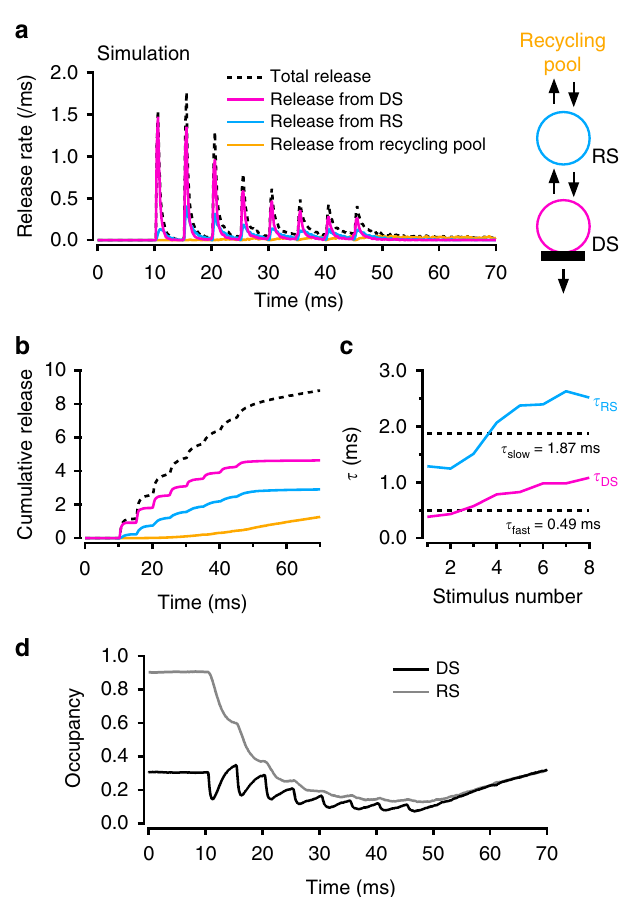
Fig. 5 Three modes of SV release during an AP train. Monte Carlo simulations were used to trace back each released SV to its status immediately before the last AP preceding release. The simulations used a modi fi ed 2-step model incorporating inhibition of release linked to previous synapse history (Supplementary Fig. 6). a Having sorted out each release SV according to its status just before the AP preceding release, the total histogram of release latencies (dashed line) was decomposed into release from docking site (red), release from replacement site (blue; note slower time course of this component) and release from recycling pool (yellow). b Cumulated plots from a . c Monoexponential fi ts of the red and blue components in b yield time constants τ DS (red) and τ RS (blue). Dotted lines indicate the values of τ fast and τ slow for comparison. This suggests that τ fast and τ slow correspond to the release of SVs coming, respectively, from docking sites and from replacement sites. In addition, the two-fold increase both in τ DS and τ RS indicates an increasing participation of slowed release due to previous release activity. d Occupancy of replacement site ( ρ ) and docking site ( δ ) during an